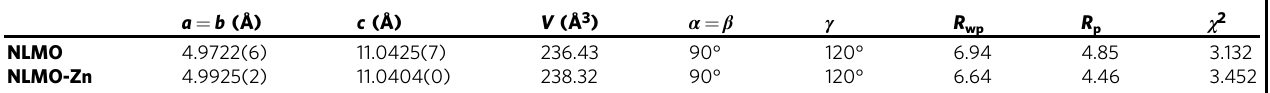
Table 1 Crystallographic parameters of NLMO and NLMO-Zn, based on Rietveld re fi nement results